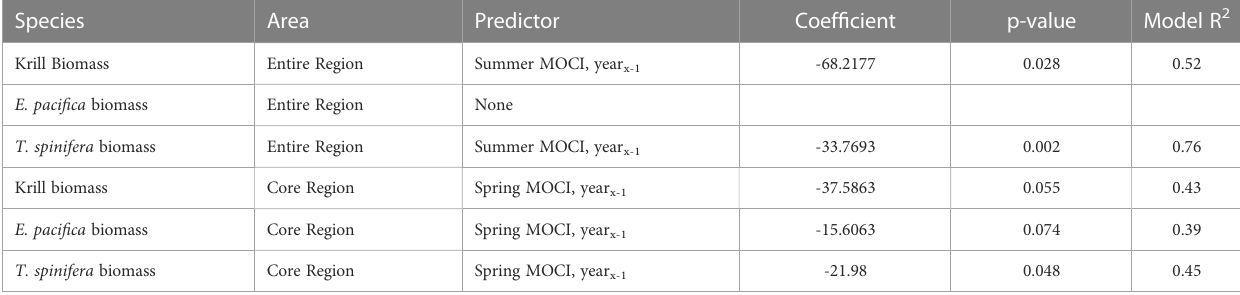
TABLE 5 Results of forward stepwise regression of krill biomass in the full and core regions predicted by seasonal MOCI.